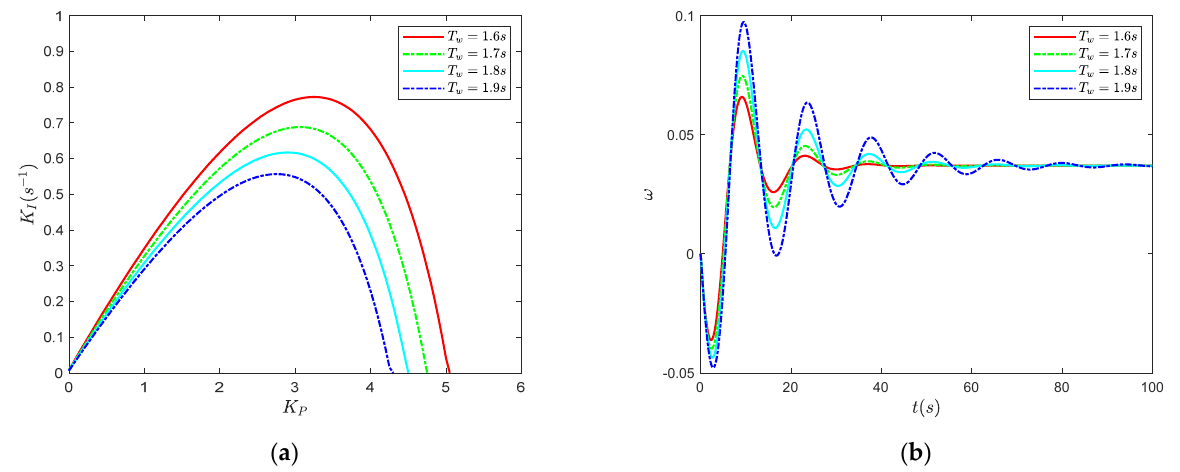
Figure 10. Effect of T w on stability and dynamic characteristics: ( a ) Stable region; ( b ) Dynamic response.